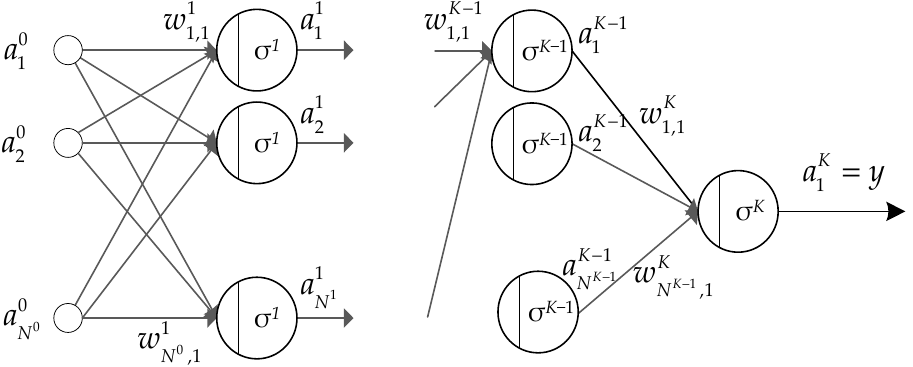
Figure 2. Multilayer neural network architecture ( 𝑁 0 inputs, 𝐾 − 1 hidden layers and 1 output).